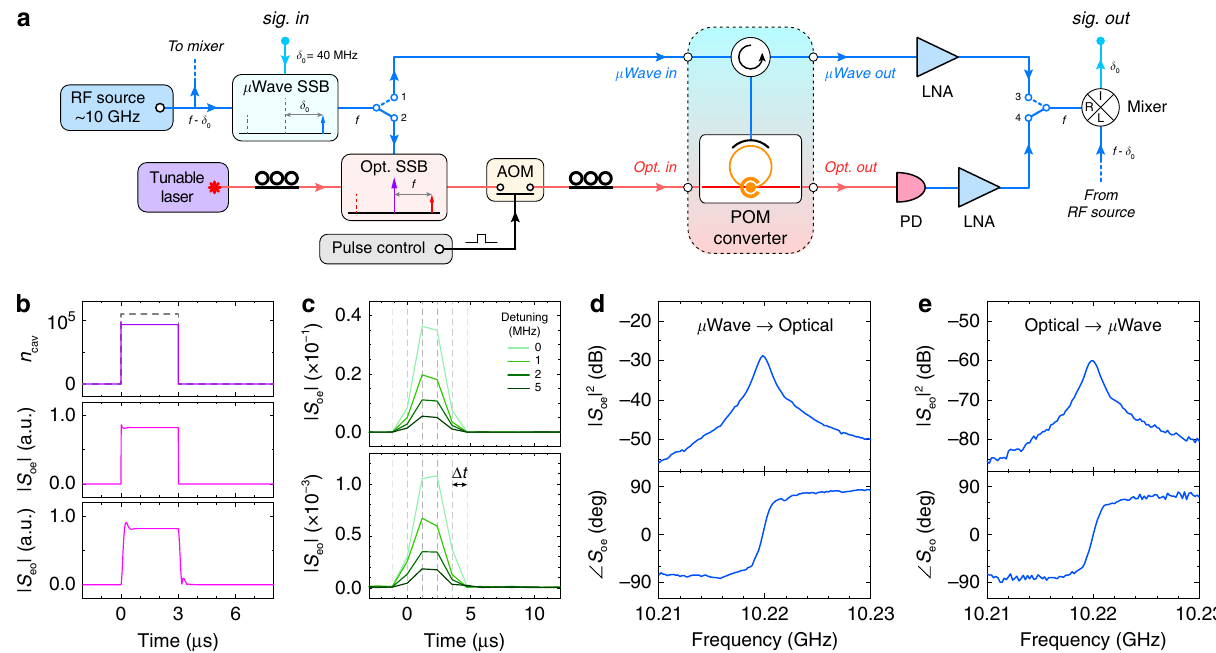
Fig. 3 Pulsed microwave-optical photon conversion. a A schematic of measurement scheme with pulsed optical pump. A 3- μ s-wide red-detuned pump pulse is generated by on/off switching using an acoustic-optic modulator (AOM). To characterize the device temporal response, a low-frequency microwave signal ( δ 0 = 40 MHz) from a lock-in ampli fi er (not shown here) is upconverted to f ~ 10 GHz around the mechanical resonance by single- sideband (SSB) modulation. The signal is then sent to the device either as the microwave input (switch pos. 1), or the optical input after the optical SSB generation (pos. 2). The microwave or optical output (pos. 3 and 4, respectively) is then downconverted to 40 MHz and sent to the lock-in ampli fi er to measure the quadratures in time domain. PD: photodetector, LNA: low-noise RF ampli fi er. b Theoretical calculation of the temporal response of the system under a pulsed pump (pro fi le indicated in gray dashed line in the top panel). n cav : intra-cavity photon number. S oe and S eo : microwave-to-optical and optical-to-microwave conversion signal, respectively. c Experimental data of the pulsed conversion signals at different input detunings from the mechanical ¼ 10 : 220 GHz ). The measurement time resolution is Δ t ≈ 1.17 μ s. d , e Coherent bidirectional microwave-optical photon conversion spectra resonance ( ω m 2 π with both amplitude and phase